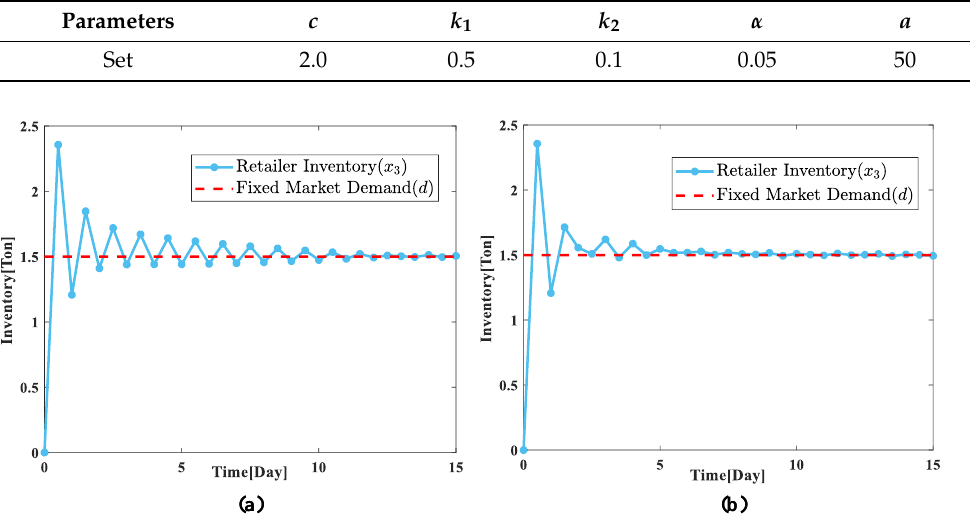
Table 2. Optimal parameters of the optimization model.